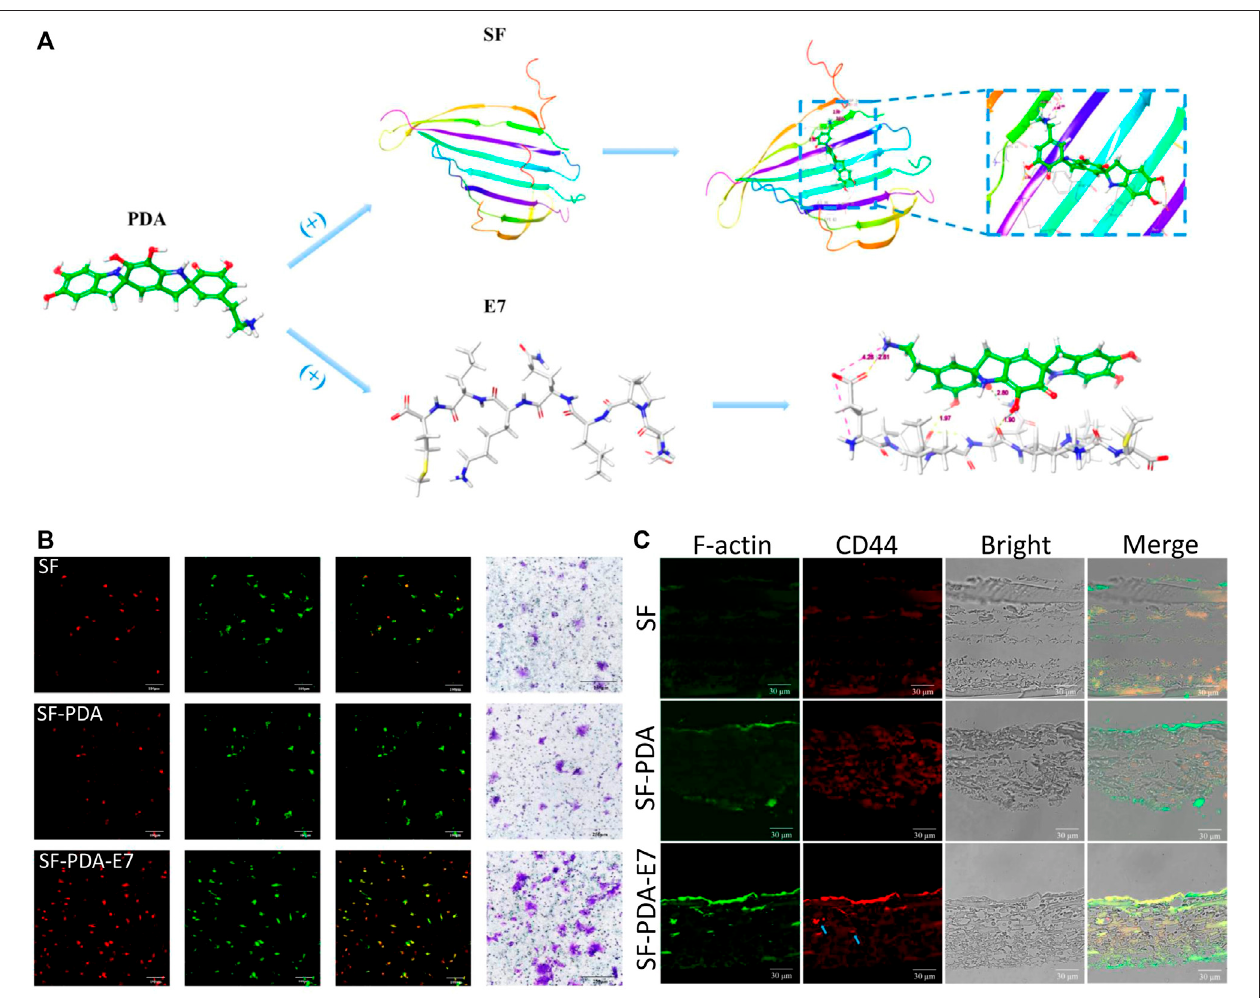
FIGURE 7 | Recruitment of BMSCs induced by E7-loaded PDA-modi fi ed silk membrane. (A) Schematic illustration of the PDA-modi fi ed silk fi broin and PDA- mediated E7 peptide; (B) CD44 immuno fl uorescent staining of the in vitro recruited BMSCs after 3 days; (C) CD44 immuno fl uorescent staining of the in vivo recruited BMSCs after 7 days. Blue arrow: the BMSCs grew into the scaffolds (Wu et al., 2019). Copyright 2019, American Chemical Society.